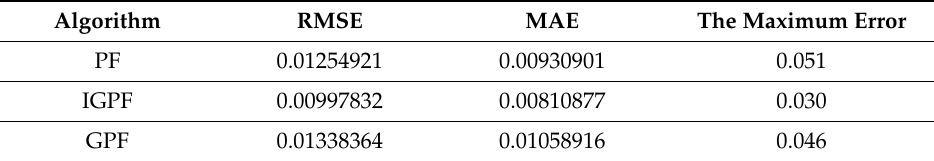
Table 5. Avenue errors and the maximum errors of three algorithms.